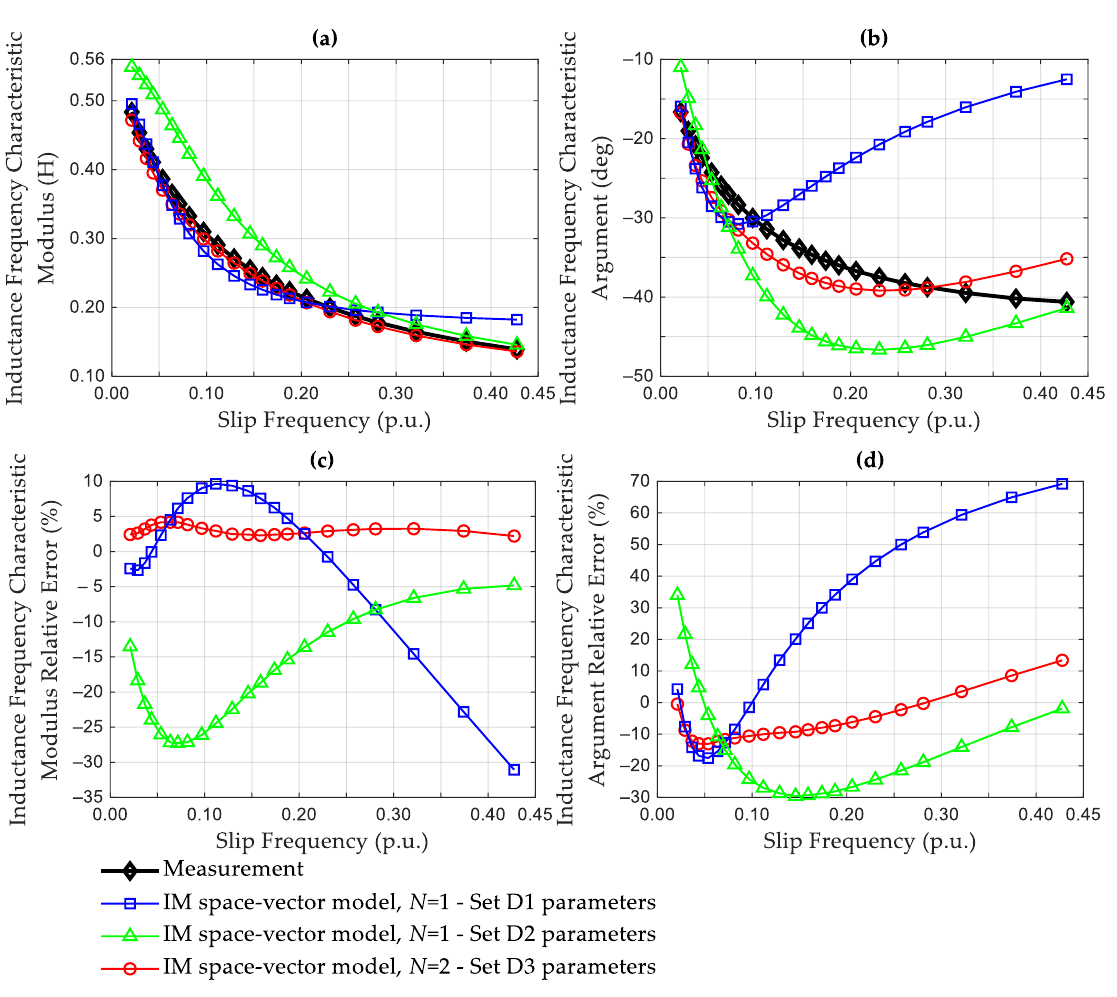
Figure 5. The SR IM inductance frequency characteristic and its approximation by the space vector models: ( a ) modulus; ( b ) argument; ( c ) modulus relative errors; and ( d ) argument relative errors.